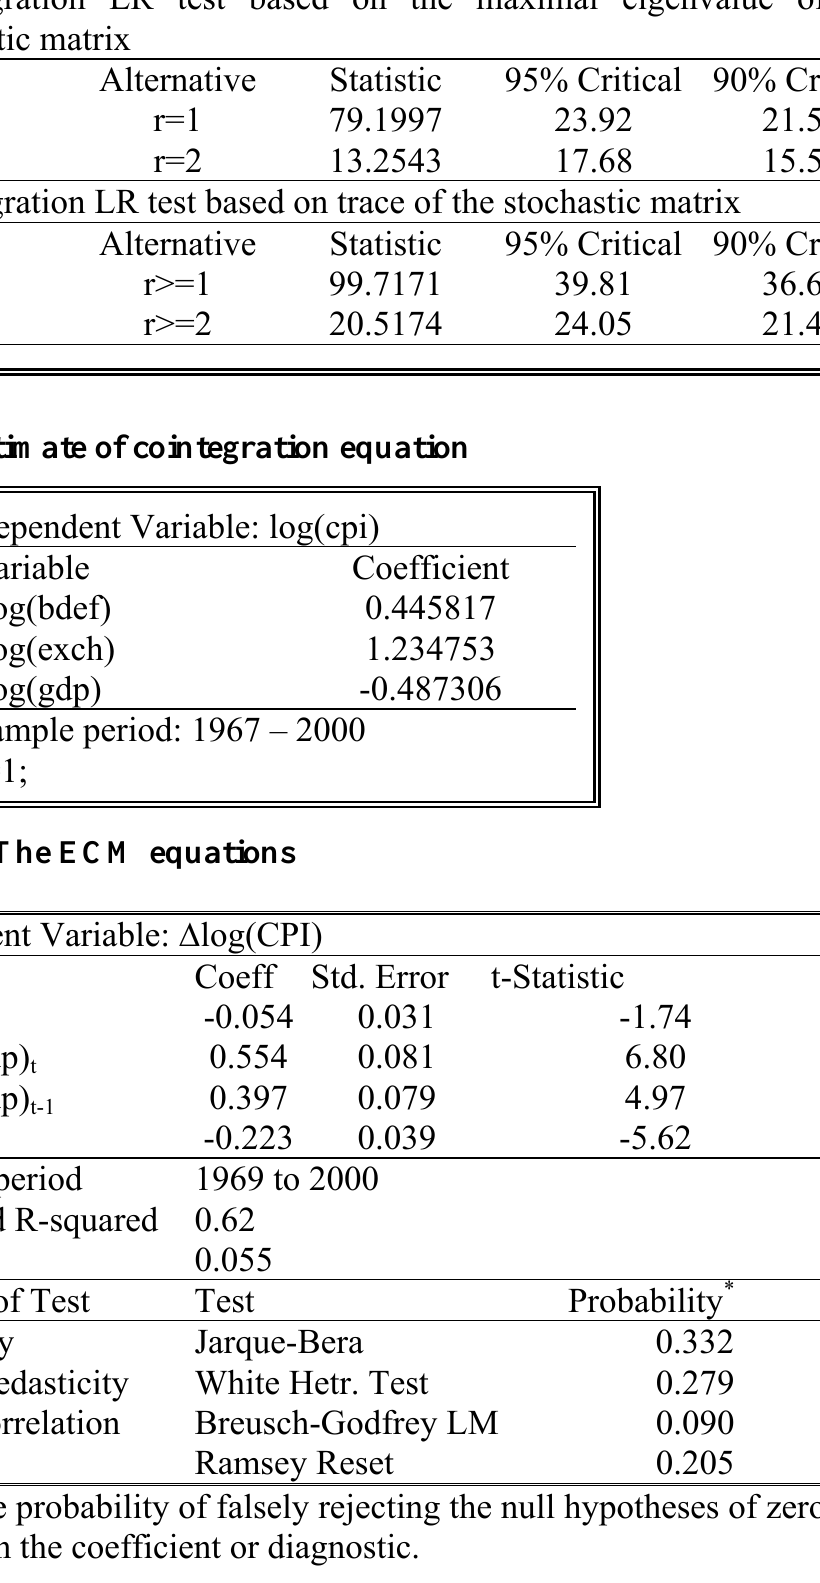
The Johansen test for the number of cointegrating relationships: consumer prices